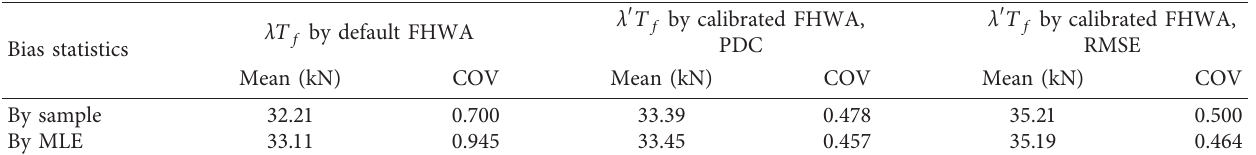
Figure 7: Histograms of facing load at h / H � 0 . 5 corrected by different biases, λ T Table 5: Summary of computed means and COVs of λ T approaches.